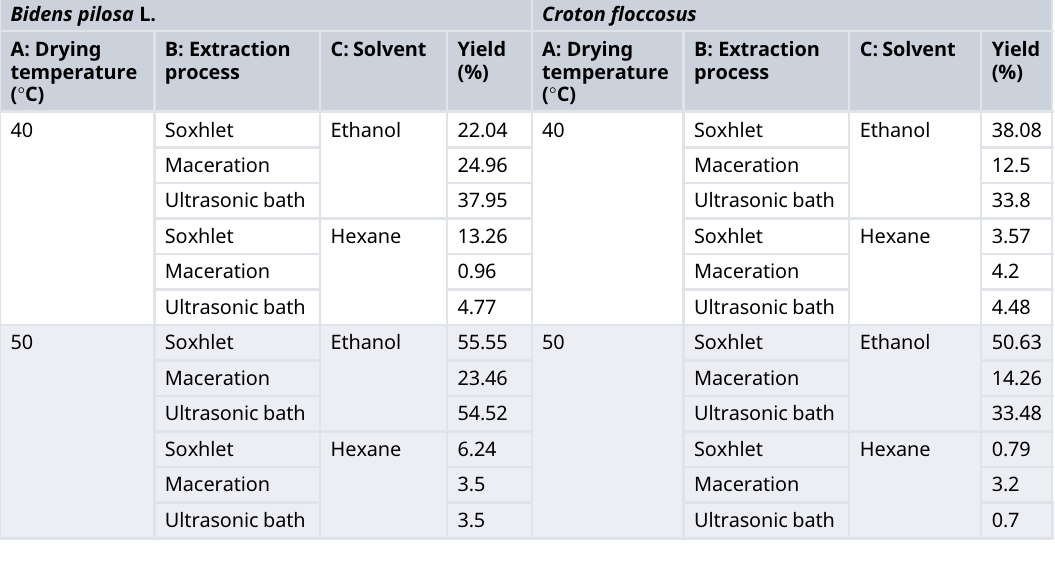
Table 1. Yields of Bidens pilosa and Croton floccosus at drying temperatures of 40 and 50 ° C. Bidens pilosa